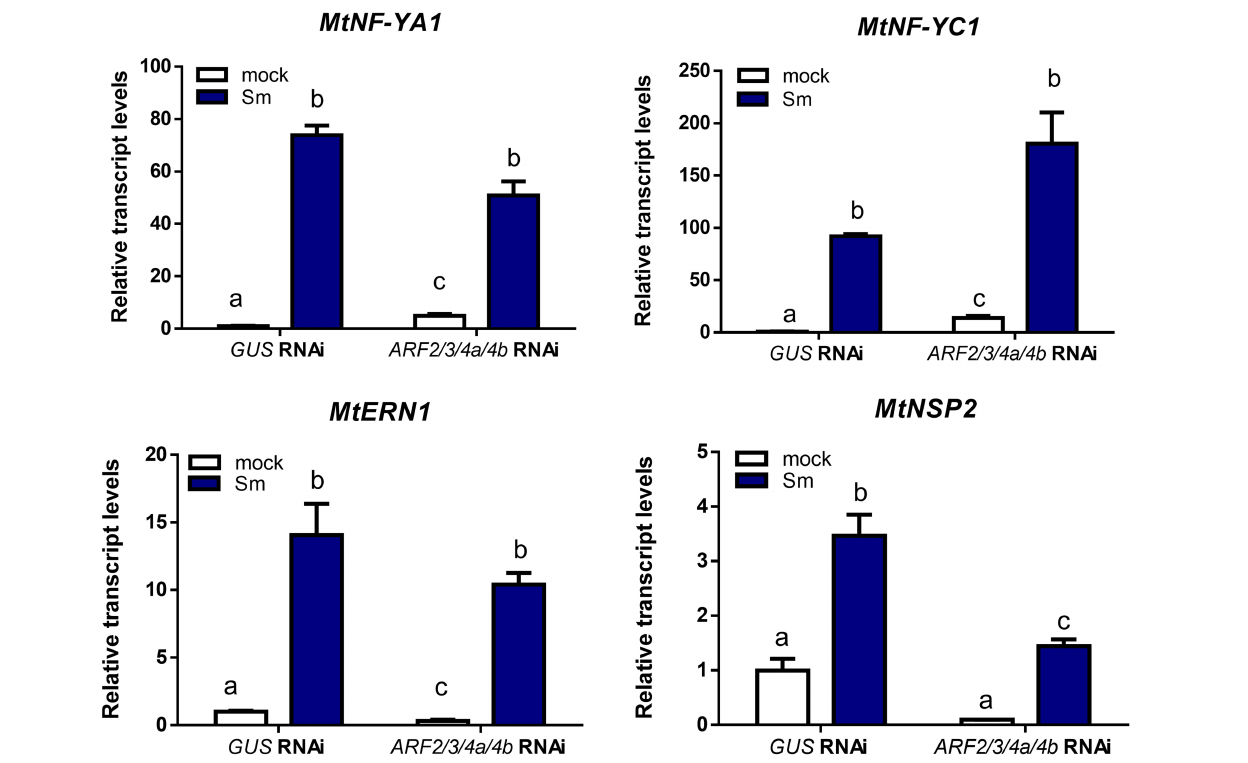
FIGURE 6 | Simultaneous knockdown of MtARF2, MtARF3, MtARF4a , and MtARF4b interfered with up-regulation of NSP2 by rhizobia inoculation. Transcript levels of early nodulation markers MtNF-YA1 , MtNF-YC1 , MtERN1 , and MtNSP2 in GUS and ARF2/3/4a/4b RNAi roots at 48 h post-inoculation (hpi) with S. meliloti (Sm, blue bars) or water (mock, white bars) were determined by RT-qPCR, normalized to MtHIS3L , and expressed relative to the GUS RNAi mock sample. Different letters indicate statistically significant differences in an unpaired two-tailed Student’s t test with a p value ≤